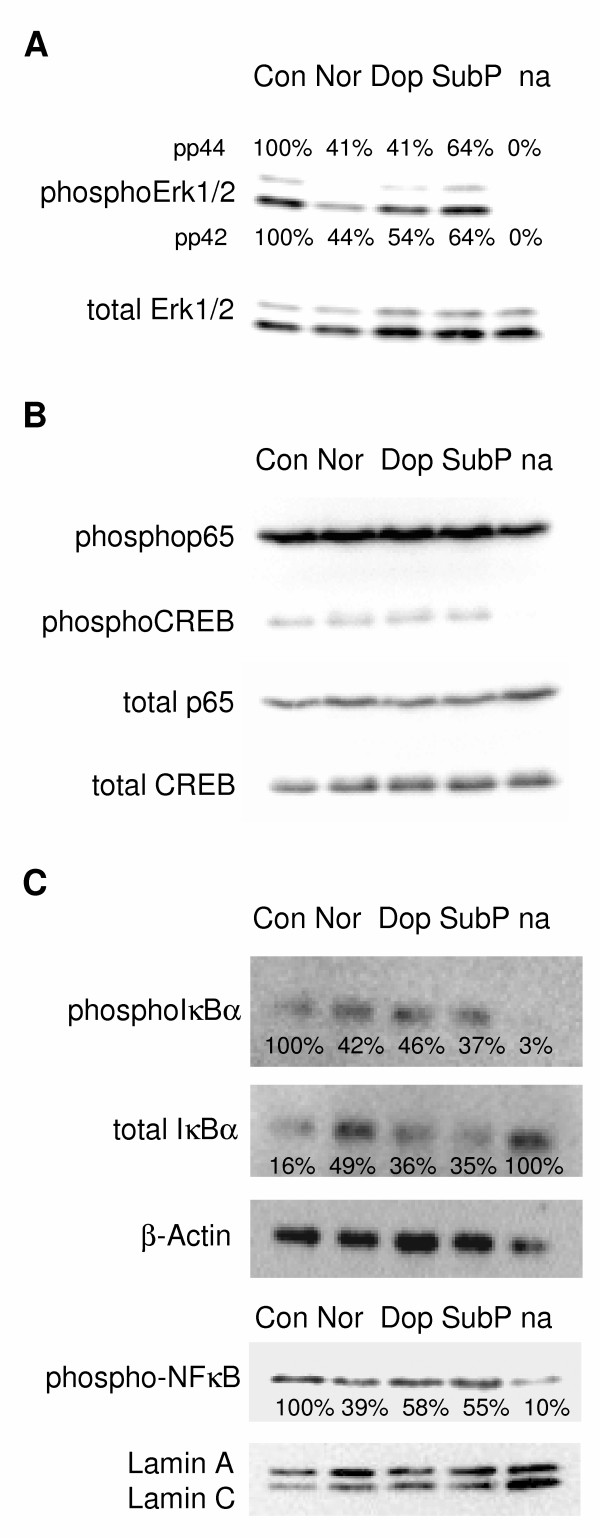
Transcription factor activation. (A) Immunoblots of total Erk1/2 and phosphorylated Erk1/2, (B) immunoblots of total and phosphorylated p65 and CREB, and (C) immunoblots of total and phosphorylated IκBα in CTL during activation, and of phospho-NF-κB in the nuclear fraction. β-Actin and Lamin A/C concentrations were used as standards to adjust the applied protein amounts. Abbreviations are: Con = control; Nor = norepinephrine; Dop = dopamine; SubP = substance P; na = non-activated control. (D) Neurotransmitters were added at 10 μM (norepinephrine) and 1 μM (substance P and dopamine) in all experiments.